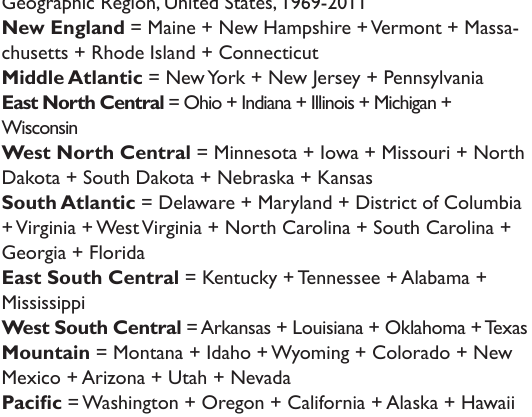
Figure 1 . Trends in Cardiovascular Disease (CVD) Mortality by Geographic Region, United States,